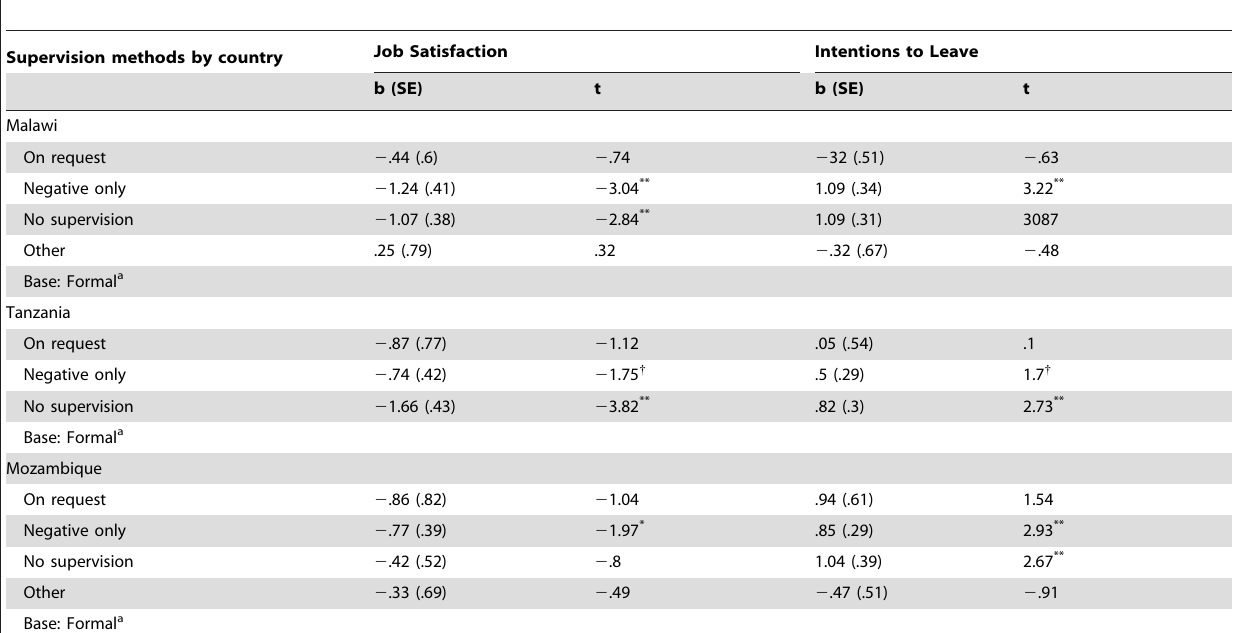
Table 3. Results of multilevel model testing the relationship between supervision methods and job satisfaction and intentions to leave across three